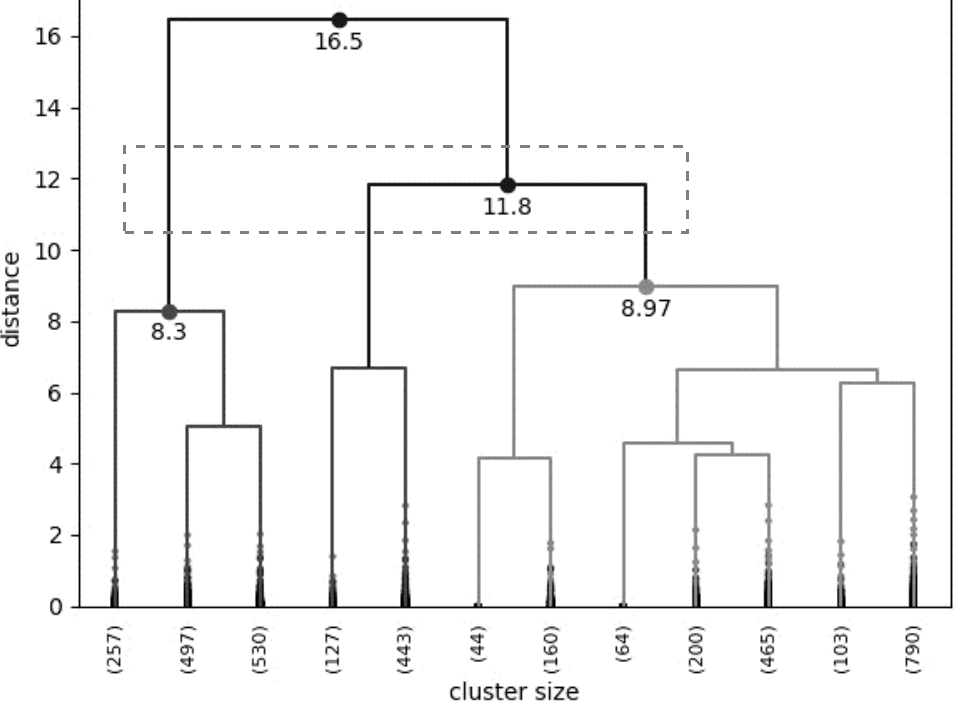
Figure 4. Dendrogram for all candidates for all COBIT dimensions